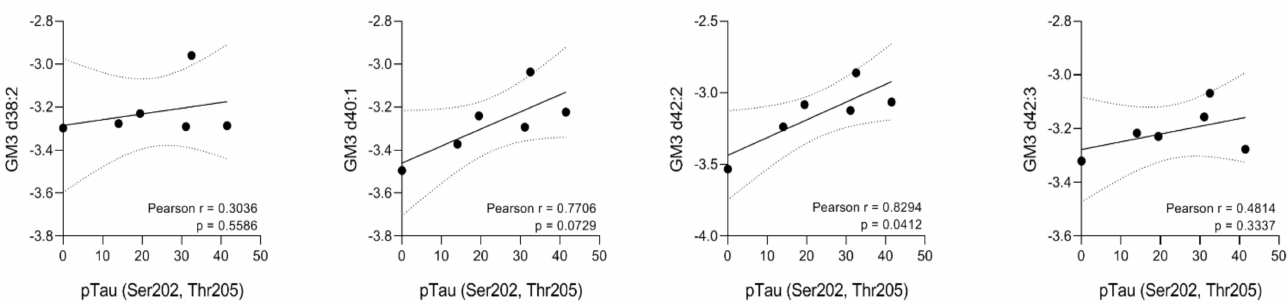
Figure 6. Correlation analysis between the most significantly upregulated GM3 ganglioside species and the amount of aggregated forms of tau protein in brain tissue. Pearson’s r was used for the calculation of correlation